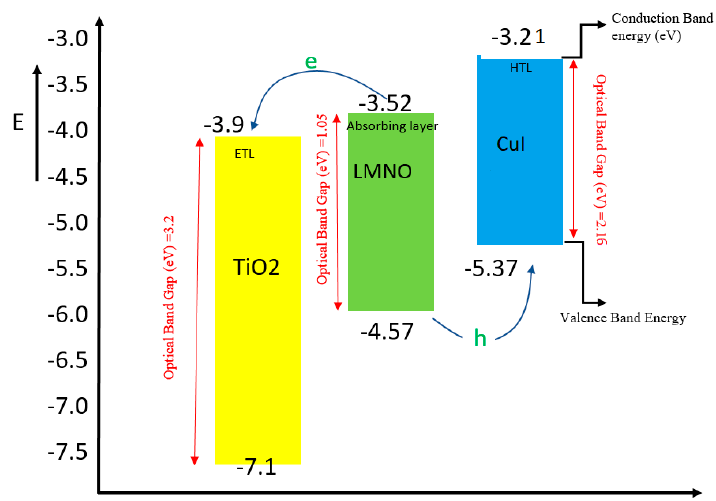
Figure 10. Energy-level diagram of structure C60/LMNO/Cu 2 O.